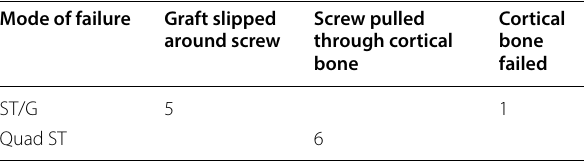
Table 2 Mode of catastrophic failure results Mode of failure